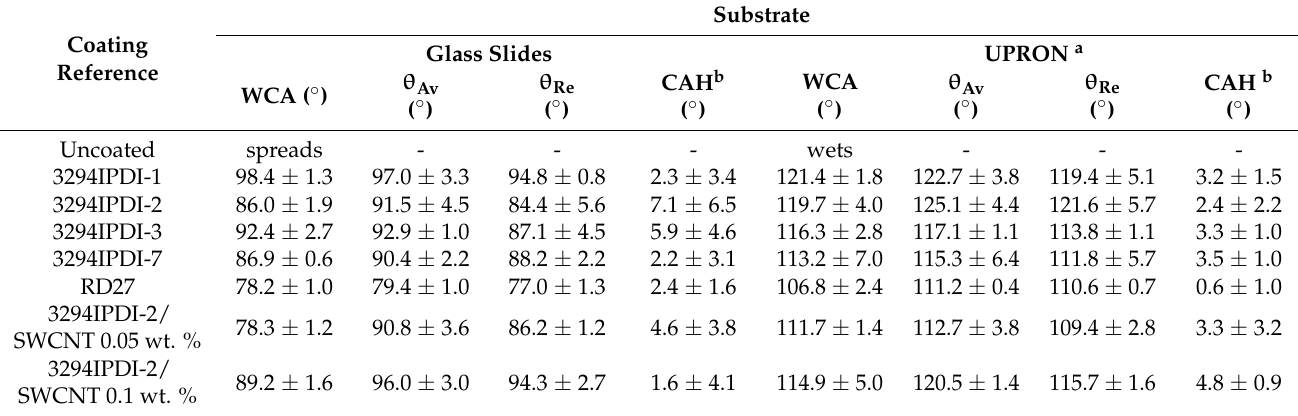
Table 8. WCA, θ Av , θ Re , and calculated CAH of glass and UPRON substrates coated with WPUD and RD27.